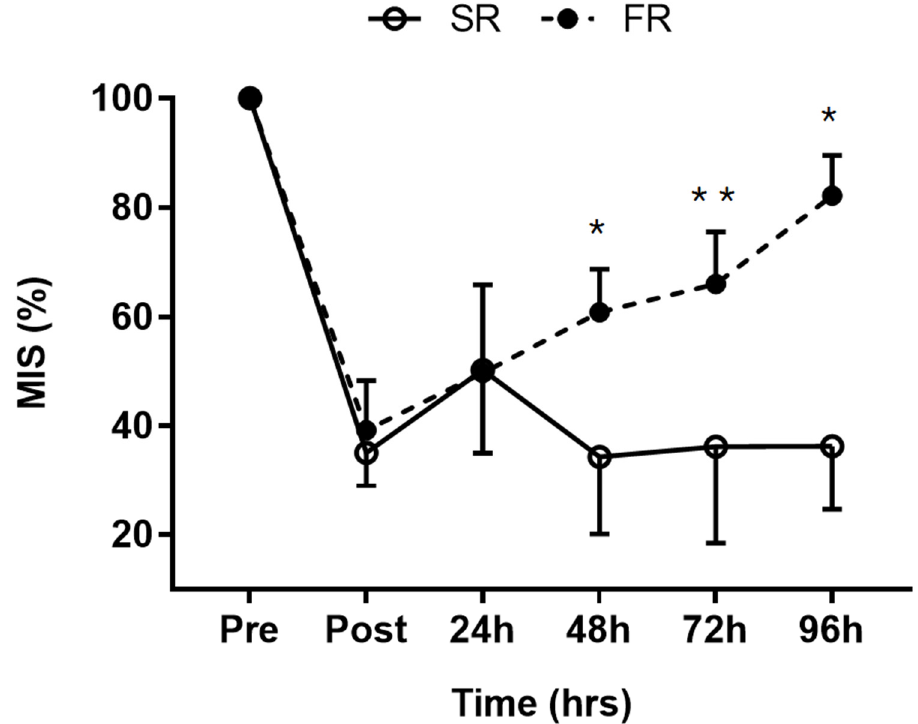
Figure 1. Changes in maximal isometric strength (MIS) in response to strength recovery after eccentric exercise. SR refers to subjects (n = 8) with slower recovery ( < 40%), and FR refers to subjects (n = 8) with faster recovery ( > 80%). * Significant between groups ( p < 0.001), ** Significant between groups ( p < 0.01). Values are means ± SD.